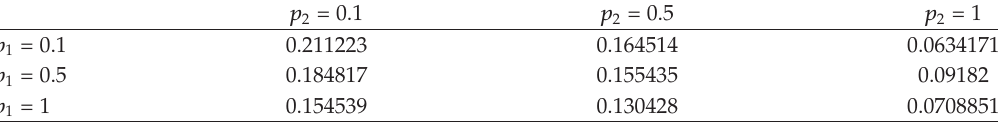
Table 4: MSV of filtering errors x 2 (cid:5) k (cid:6) − (cid:11) x 2 (cid:5) k/k (cid:6) , k (cid:7) 1 , 2 ,...,